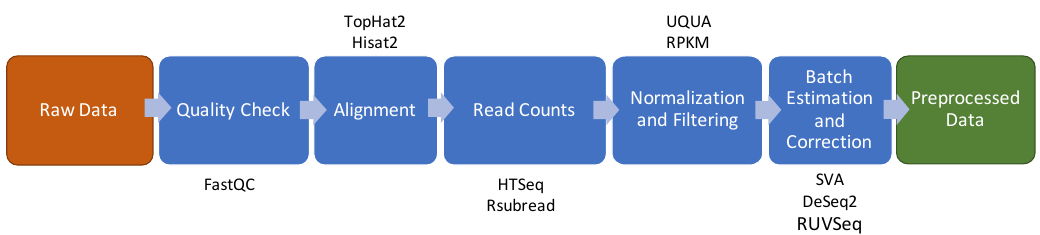
Figure 3. Data preprocessing schema for RNA-Seq. The brown box indicates the input of the pipeline. The green box indicates the output of the pipeline. The blue boxes show the intermediate steps of the pipeline and above or below the boxes are shown the software/packages employed in the